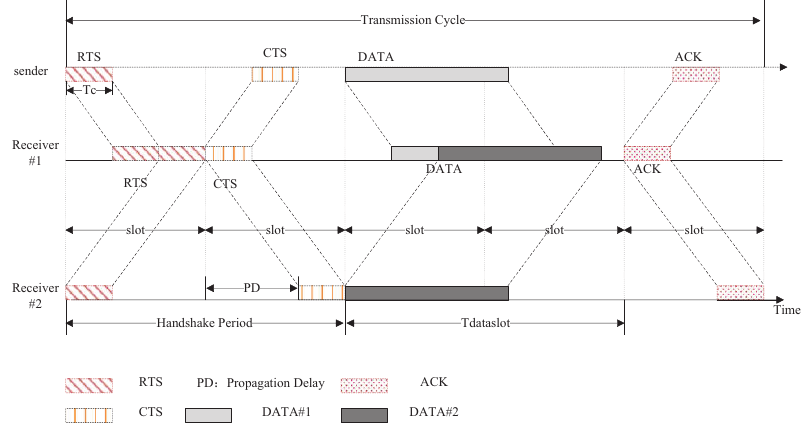
Figure 2. A transmission cycle in